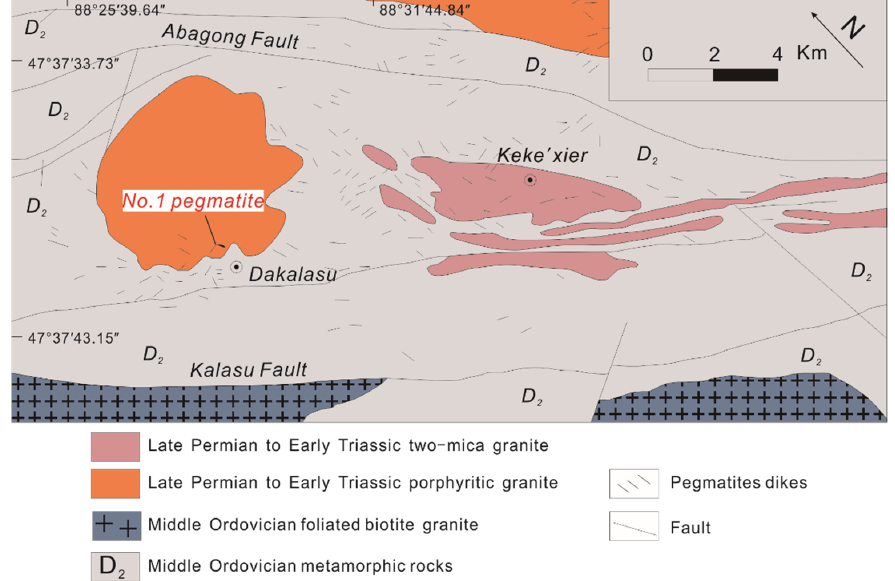
Figure 2. Schematic Geological Map of the Dakalasu-Kekexi’er pegmatite field, modified after [16,17].